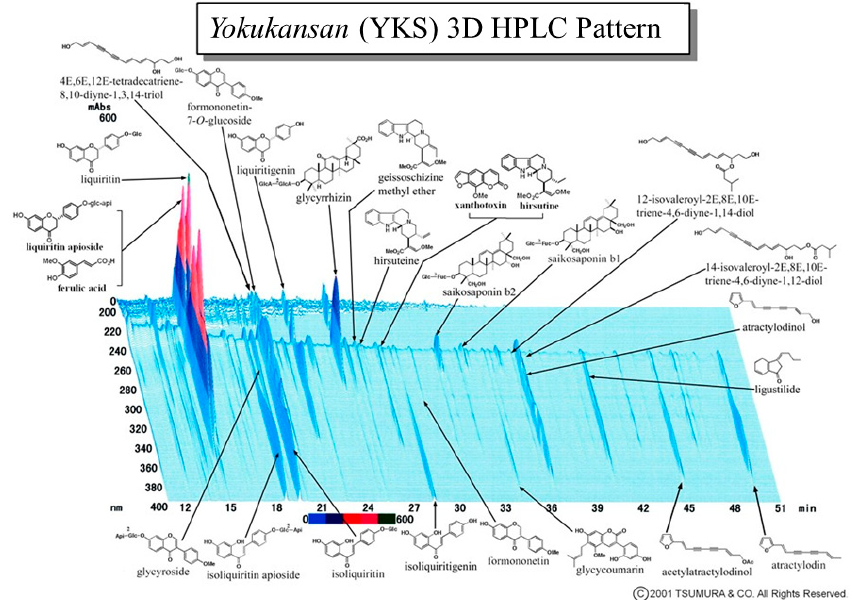
Figure 1. Three-dimensional high-performance liquid chromatography (3D-HPLC) profile chart of the major chemical compounds in Yokukansan the major chemical compounds in Yokukansan (YKS).